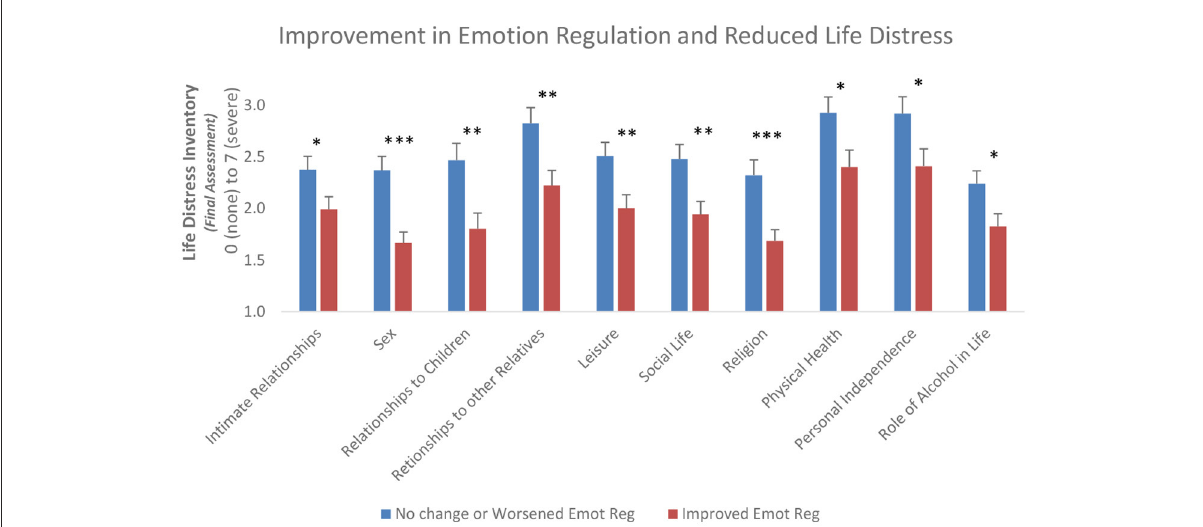
FIGURE3 Improvement in Emotion Regulation associates with decreased Life Distress at final assessment. Participants whose Emotion Regulation improved over the course of the program also had less life distress in 10 of 18 areas at their final assessment. Participants who have overall improvement in Emotion Regulation (DERS-SF) (red bars) compared to those without improvement (blue bars) during the Roca CBT intervention demonstrate statistically significant lower life distress at the final assessment for 10 items on the Life Distress Inventory. Shown are mean scores + sem. * p < 0.05, ** p < 0.01 and *** p <